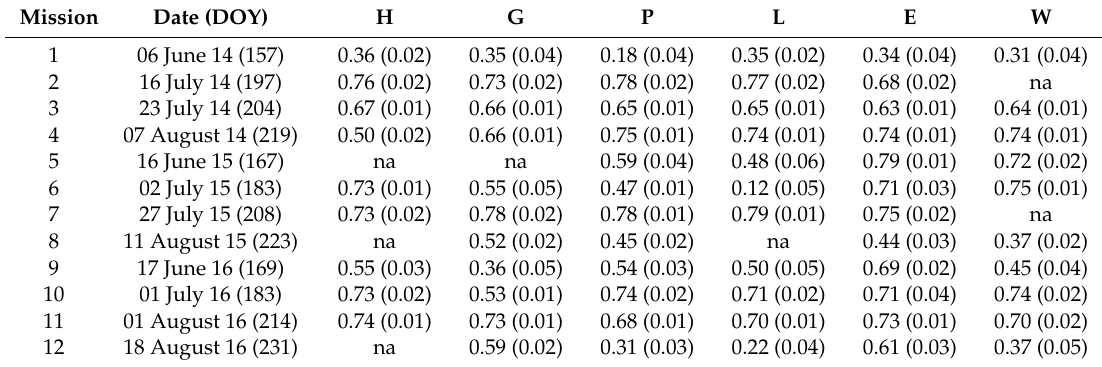
Table 5. Field ET estimates (mm hr − 1